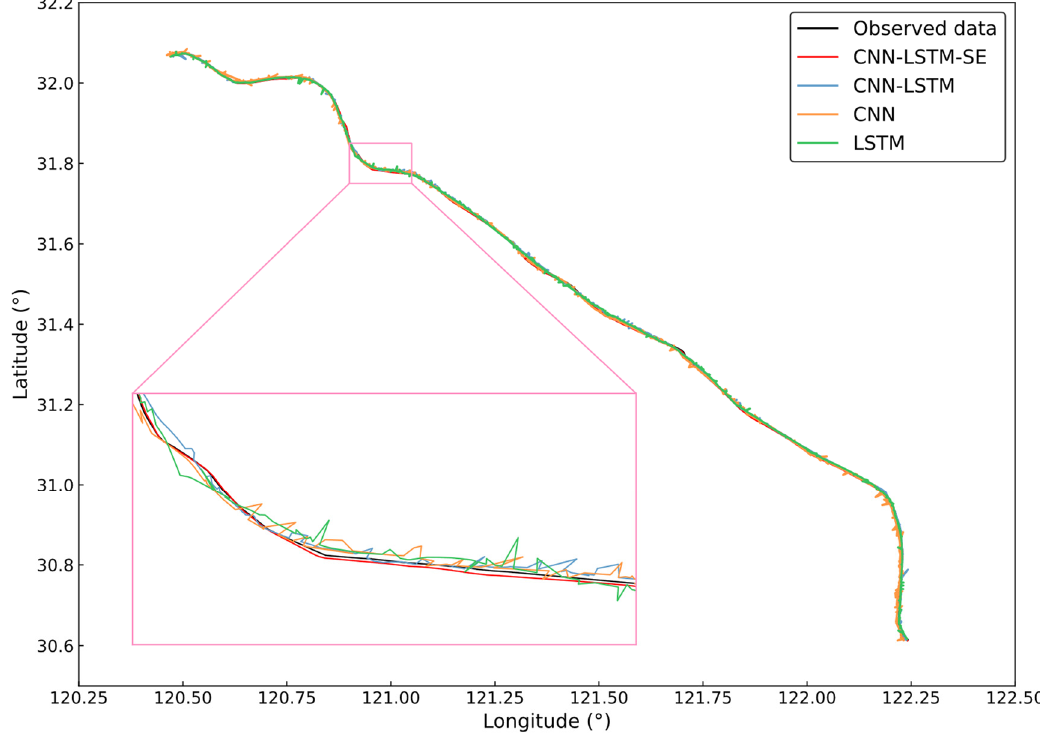
Figure 6. Performance of prediction models for ship-1 with a time interval of 10 s.